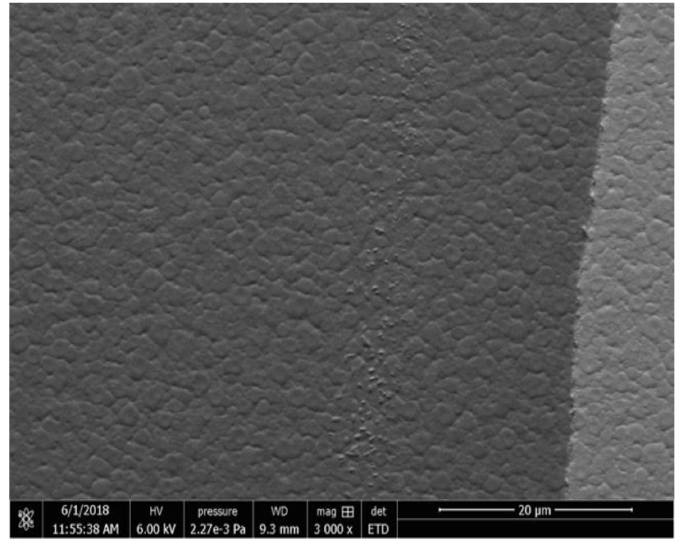
Figure 3. Scanning electron microscope (SEM) micrograph showing a crystal-growth PCT thin film annealed at 600 ◦ C.